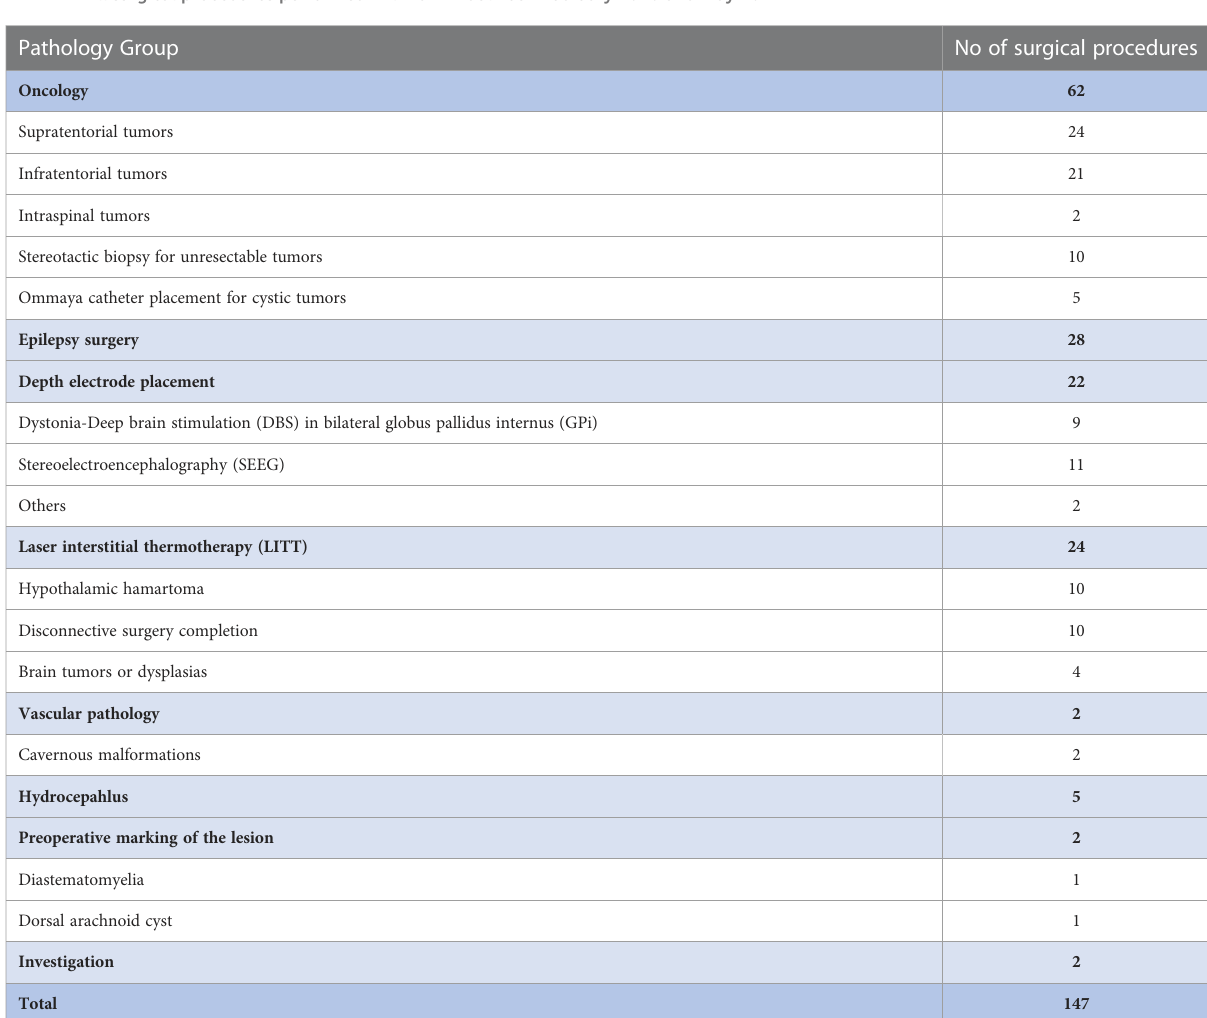
TABLE 1 All surgical procedures performed with ioMRI between February 2020 and May